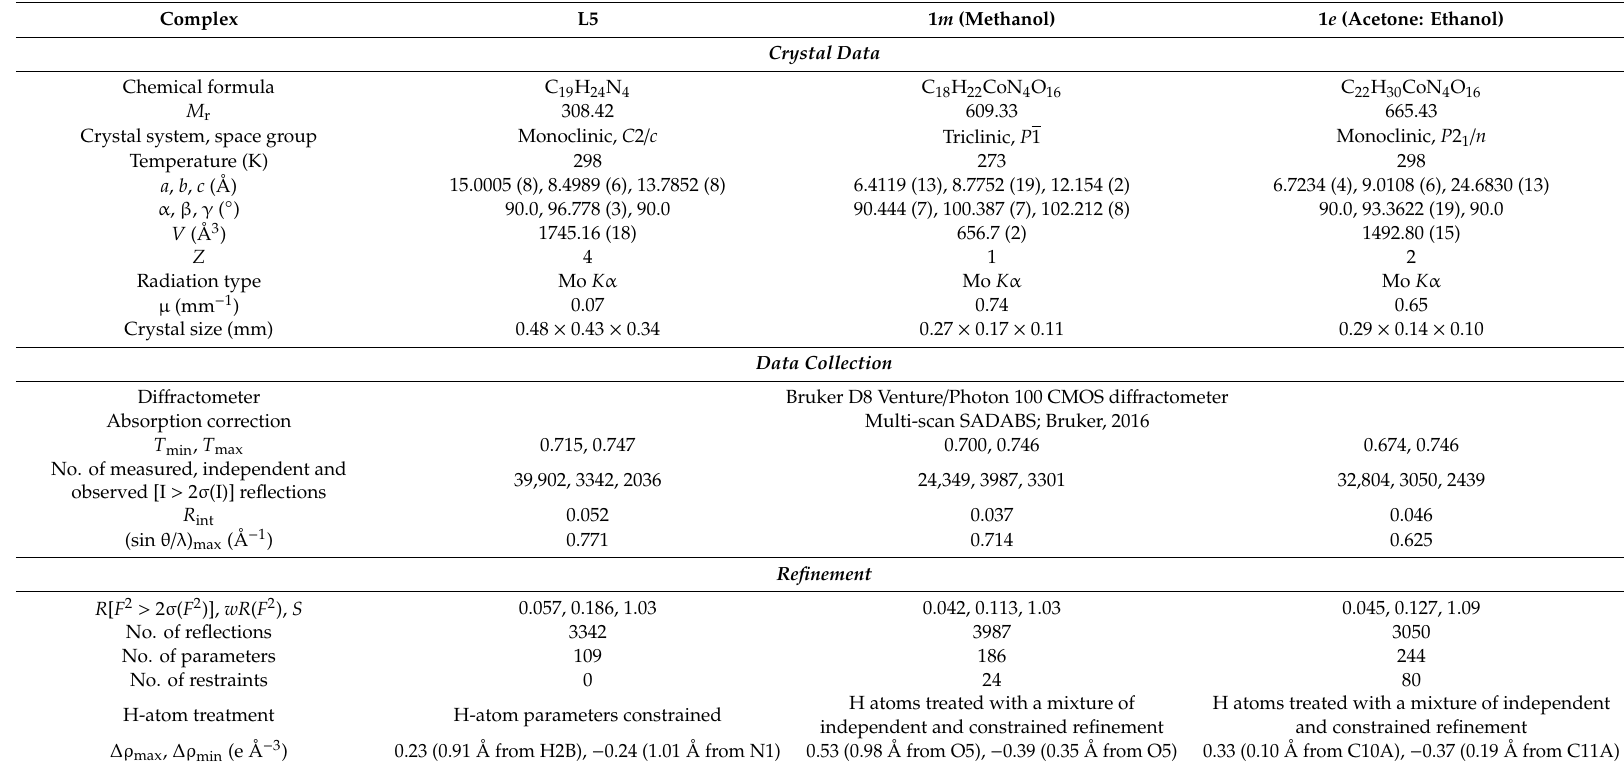
Table 3. Crystal data and experimental